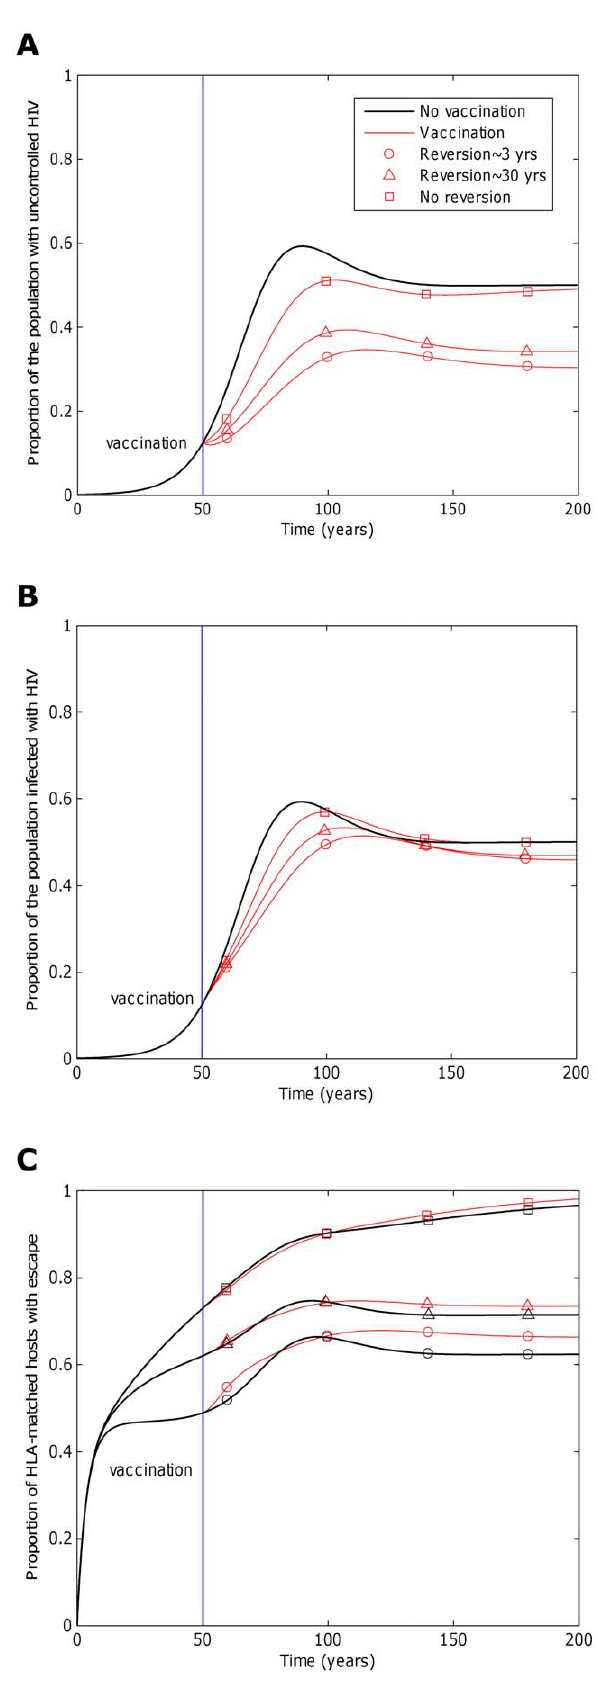
Figure 4. The impact of a vaccine will be greater if the rate at which immune escape mutants revert in HLA mismatched hosts is faster. This figure explores how the rate at which immune escape mutants revert in HLA mismatched hosts affects the impact of a five-epitope vaccine delivered to the population 50 years into an epidemic. Model simulations are presented for different reversion rates: rapid reversion (circles; y i ~ 1 = 3 years 2 1 for i =1:5), slow reversion (triangles;